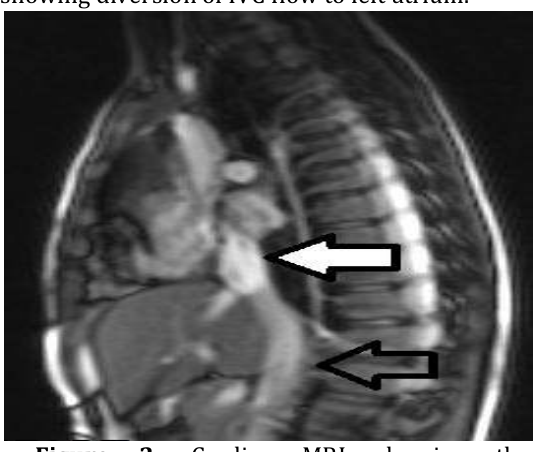
2: Cardiac MRI showing